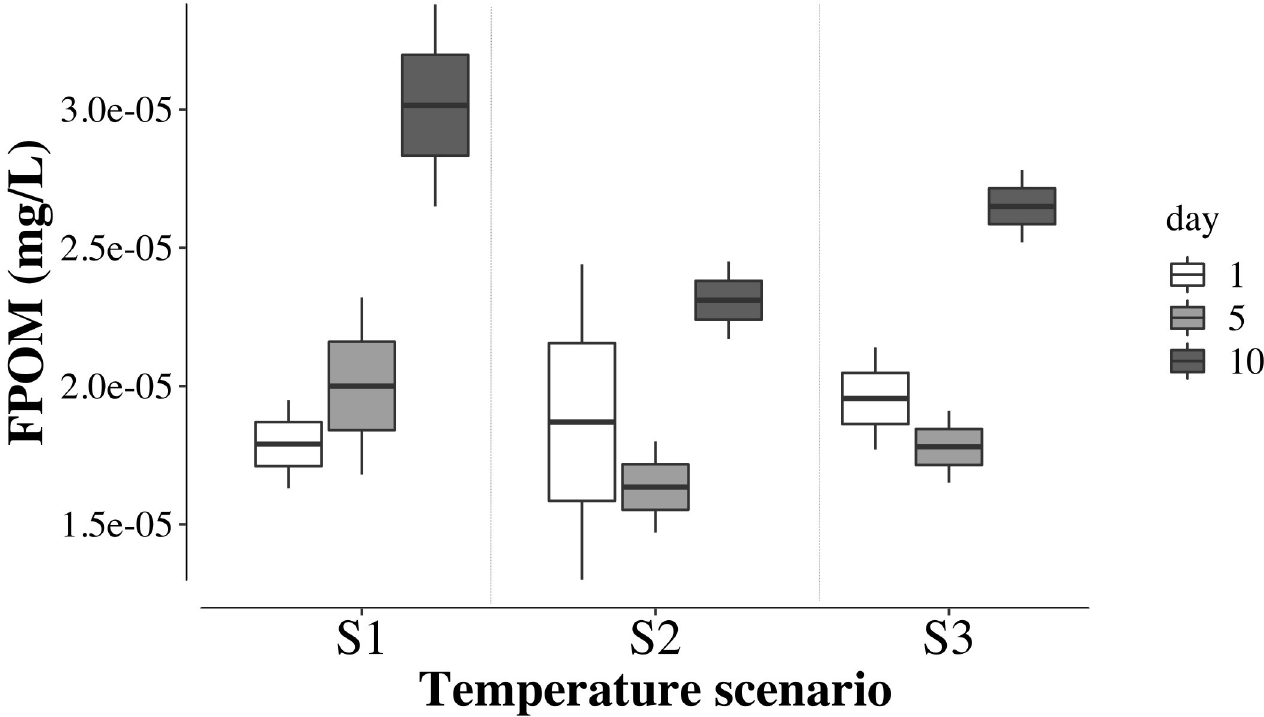
Fig 5. Fine particulate organic matter in three temperature scenarios. Boxplots of the fine particulate organic matter collected during the ten-day mesocosm experiment. The central line represents the median FPOM content. The lines above and below the box are the highest and lowest scores, respectively. The first and third quartiles are represented in the box. S1 (control), S2 (+2.5˚C) and S3 (+5˚C).